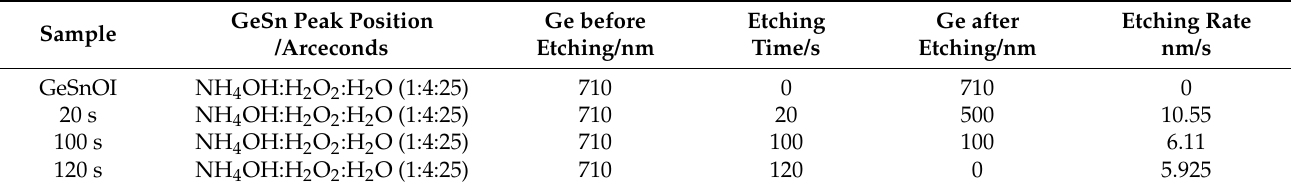
Table 1. Process details of vertical wet etching of Ge.